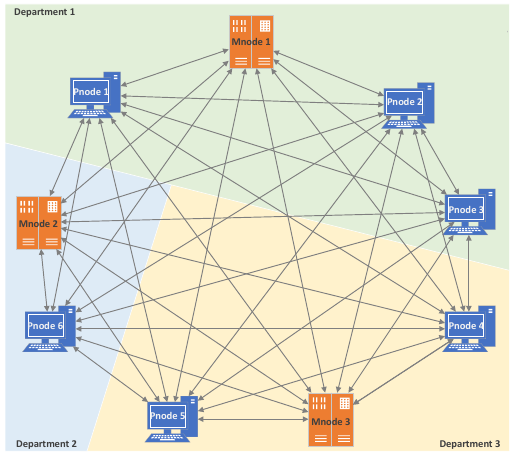
Figure 7. Topological diagram of the experimental